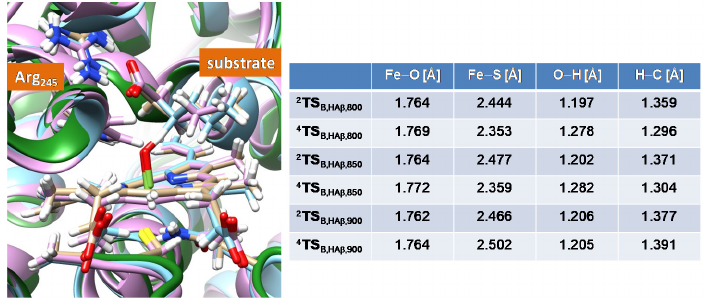
Figure 9. QM/MM optimized geometries of hydrogen atom abstraction transition states from the C α ‒ H position of substrate in the doublet and quartet spin states for snapshots Sn 800 , Sn 850 and Sn 900 . Fe ‒ O, Fe ‒ S, O ‒ H and H ‒ C distances given in angstroms, while the left-hand-side gives an overlay of the doublet spin optimized structures.